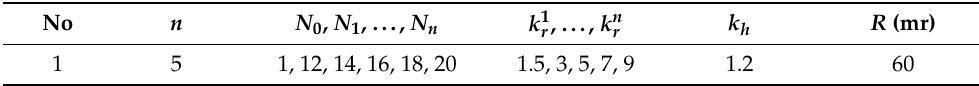
Table 4. Parameter combination adopted in this paper.